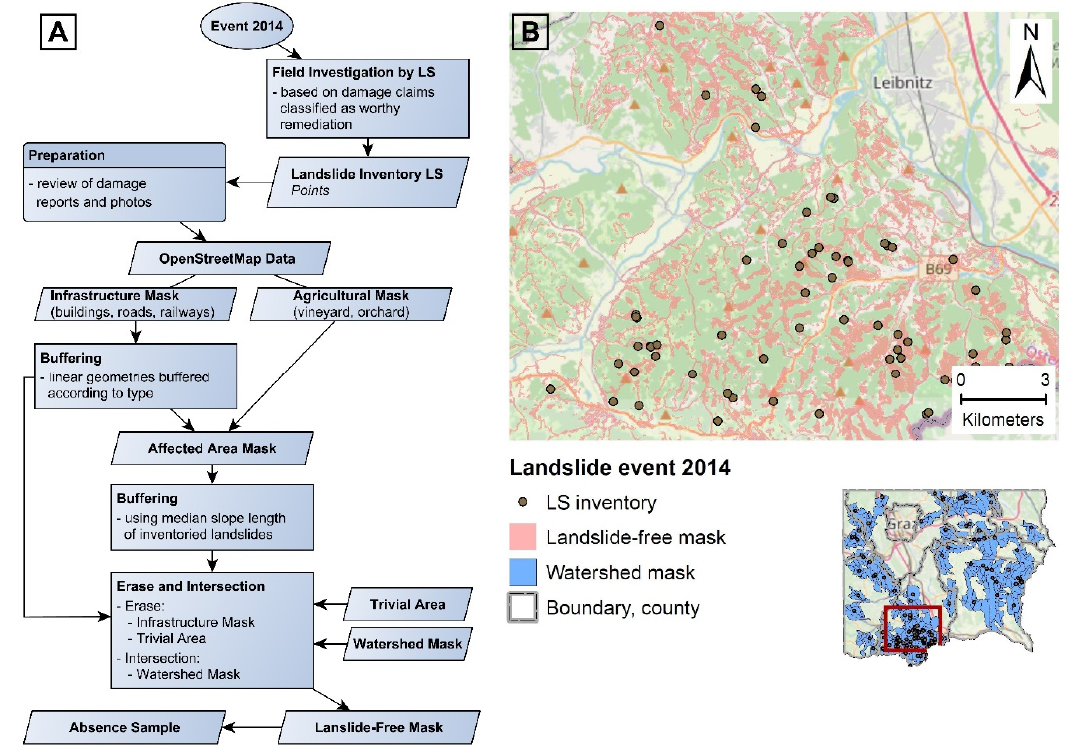
Figure 3. Overview of the sampling design for the 2014 rainfall-triggered landslide event: ( A ) Overview of the workflow; ( B ) Overview map with OSM data as background.